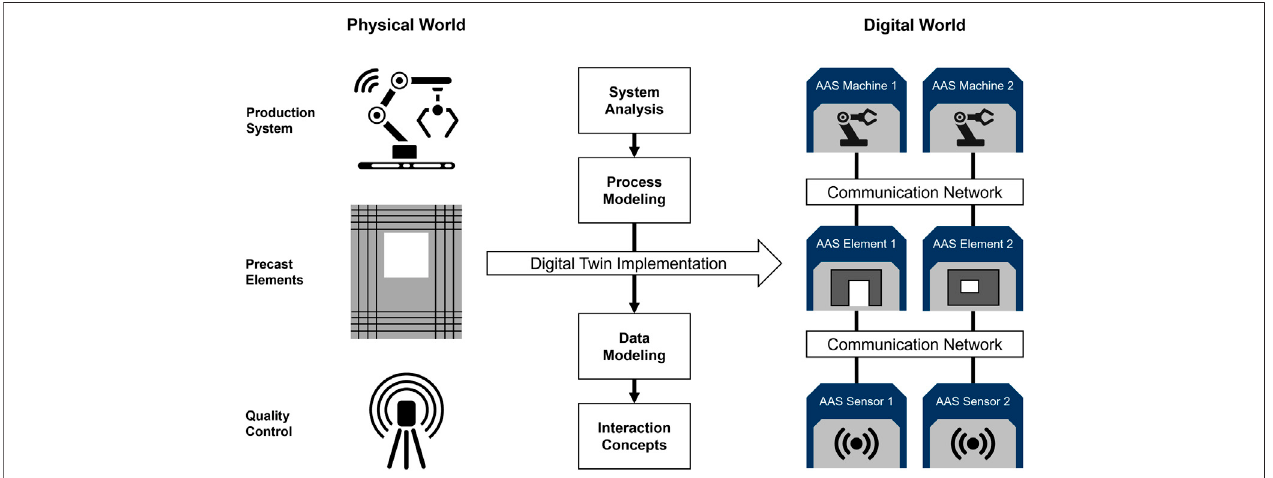
FIGURE 1 | Schematic illustration of the overall